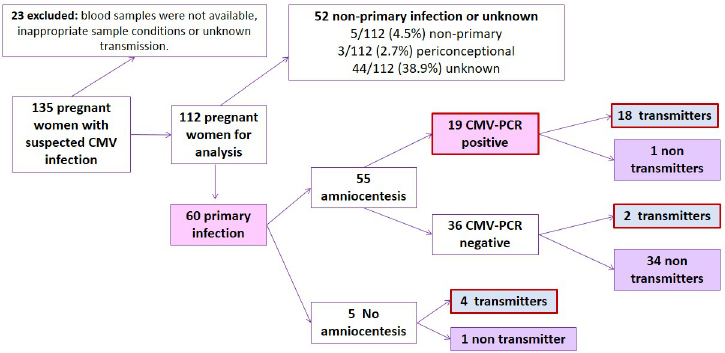
Fig 2. Patient flowchart. Flowchart showing outcome of 135 pregnant women with suspected Cytomegalovirus infection. CMV indicates Cytomegalovirus.